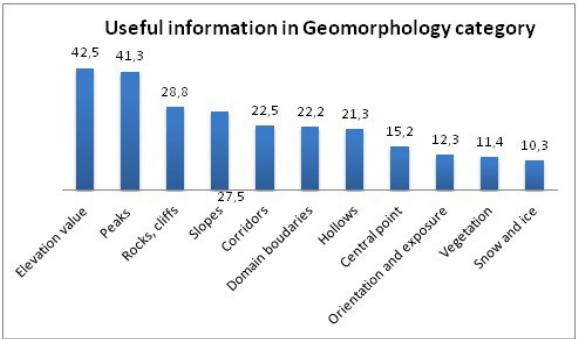
Figure 14. Percent of responses “very useful” geomorphic information depicted in the ski